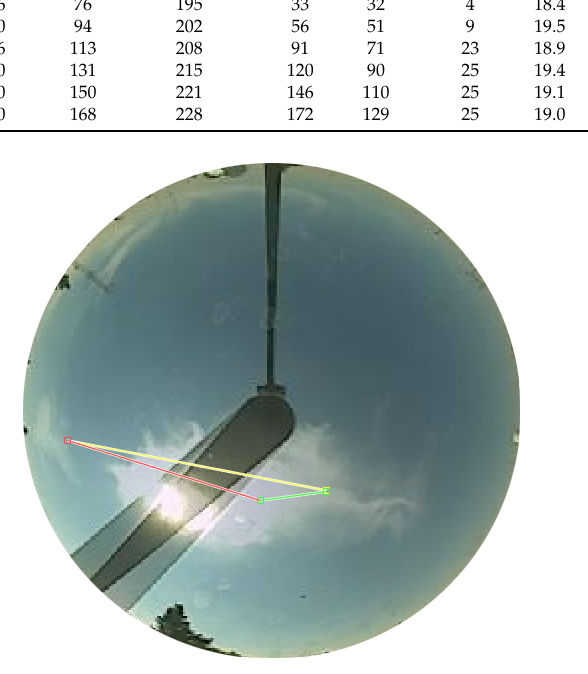
Figure 7. The yellow line is the real vector. The red line is the vector forecasting and the green line is the error between the red and yellow lines.